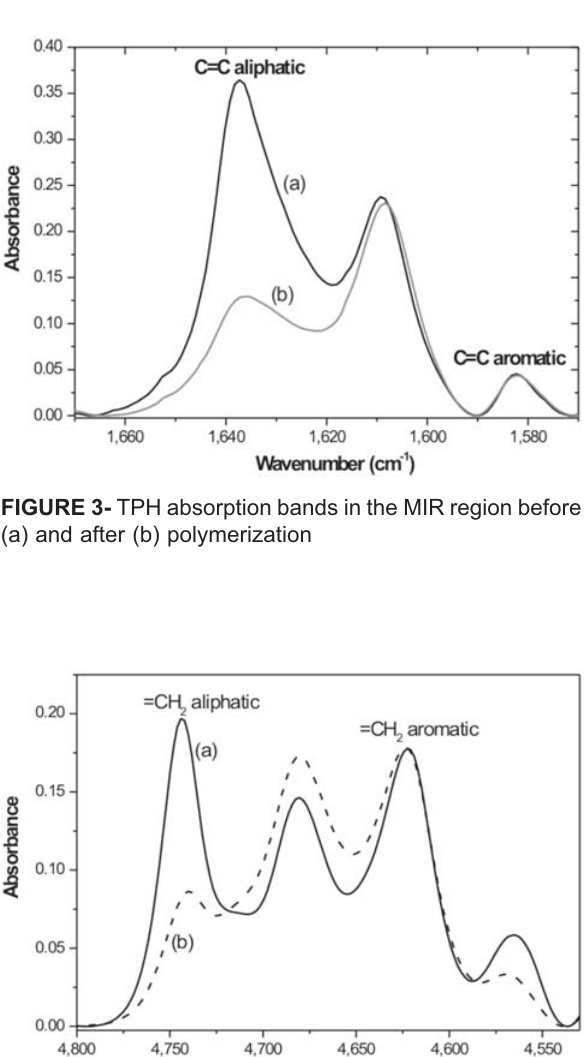
FIGURE 1- Background spectrum in NIR (a) and MIR(b) spectral regions. The horizontal bars indicate where the absorption bands used to determine the conversion degree are localized (a.u.= arbitrary units)